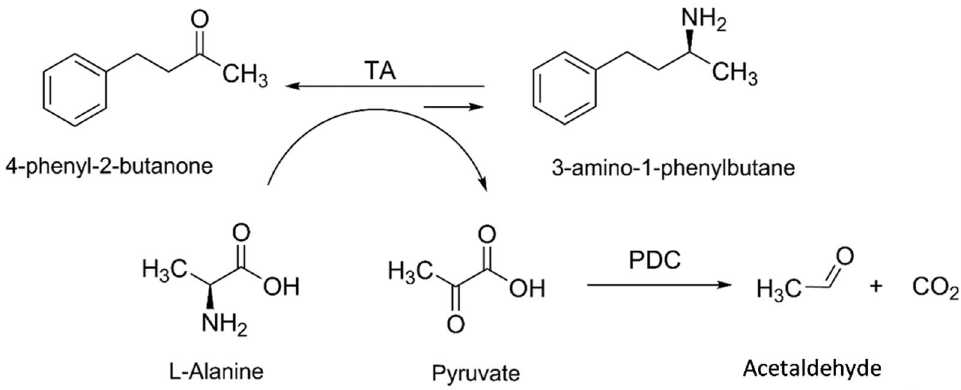
Figure 1. Asymmetric synthesis of 3-amino 1-phenylbutane (3-APB) from 4-phenyl 2-butanone (4- PB) and L-Alanine catalyzed by the TA-PDC cascade